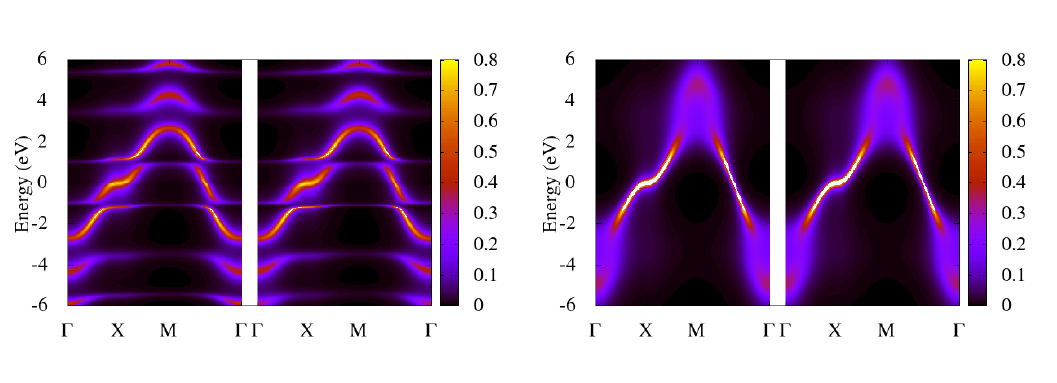
Figure 8: A ( k , ω ) for each spin component computed by (a) the ED solver with three bath sites and (b) the CT-QMC